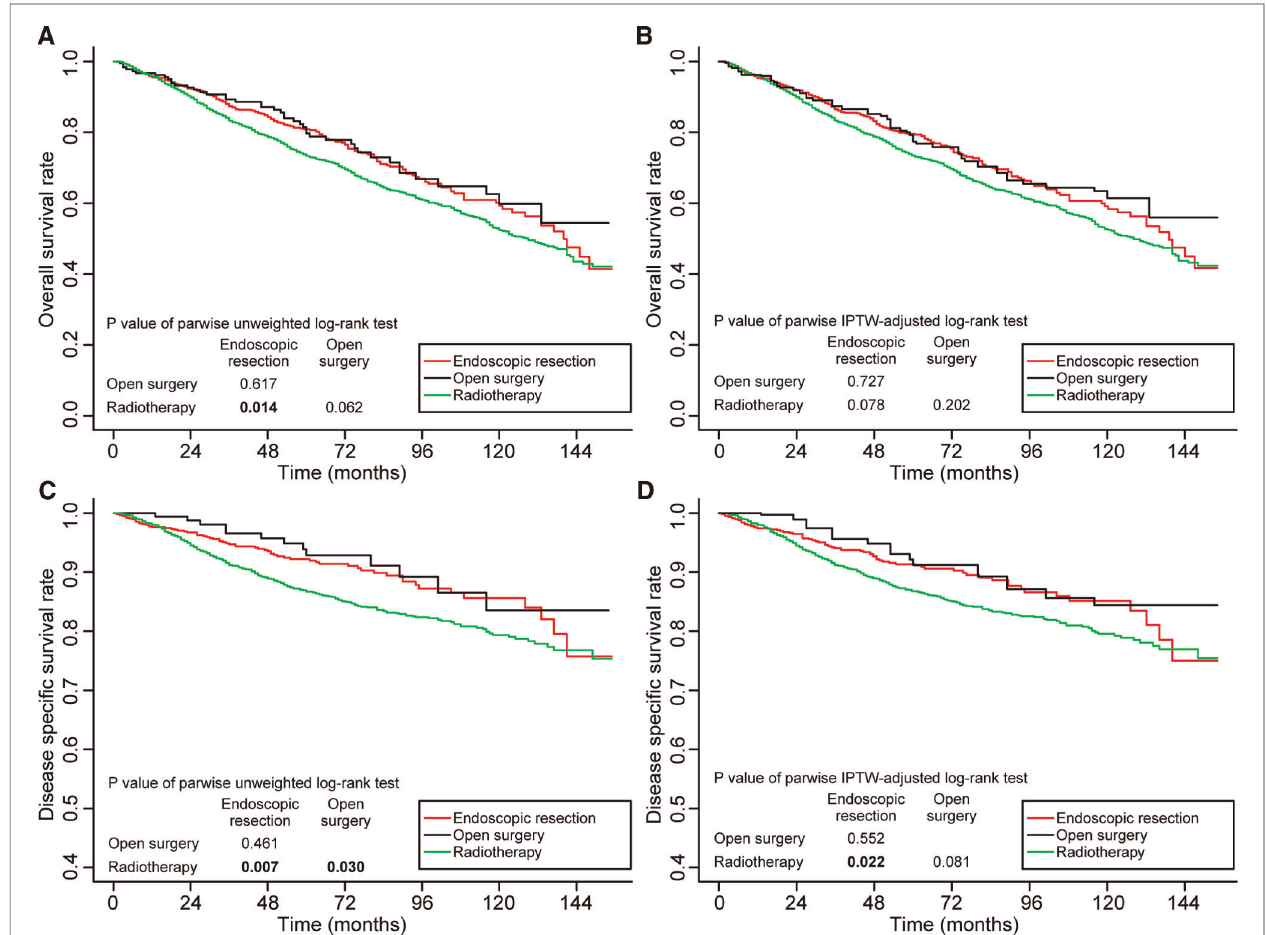
FIGURE 3 | Kaplan – Meier curves for overall survival ( A,B ) and disease-speci fi c survival ( C,D ) before and after weighting in patients with stage I disease. Signi fi cant p values are in bold font. IPTW, inverse probability of treatment